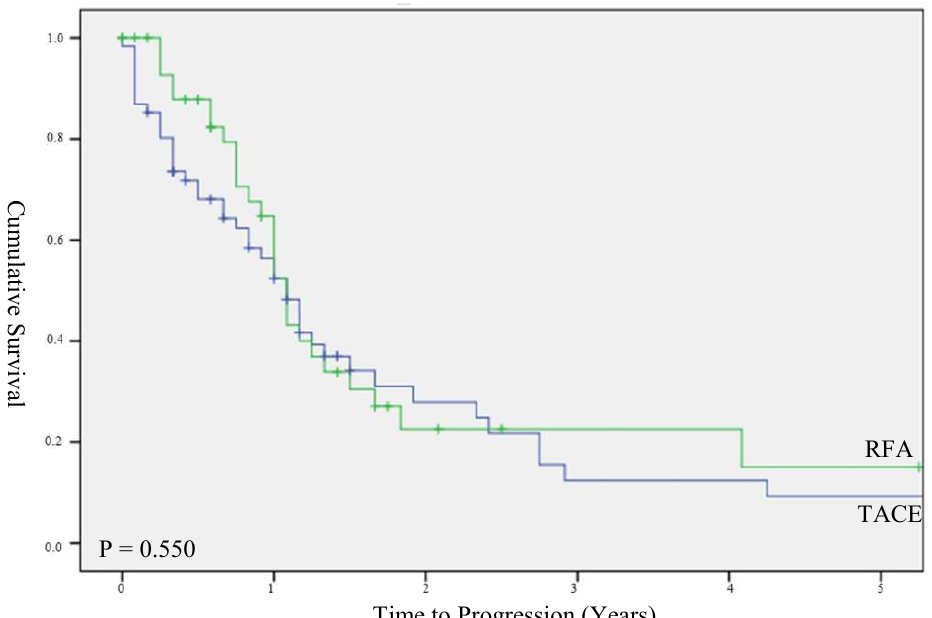
Figure 4. Time to progression stratified for HCC < 3 Fig. 4 Time to Progression stratified for HCC < 3cm Fig. 4 Time to Progression stratified for HCC < 3cm